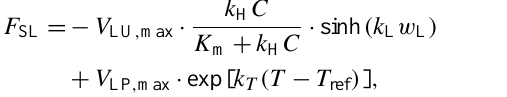
Figure 2. COS solubility function used in this study (pink), ob- tained from regression with Elliott et al. (1989) data (pink). Sol- ubility data measured under pH < 9, non-saline conditions (pink di- amonds) were used for the regression. Also plotted are the COS solubility functions from Wilhelm et al. (1977) and De Bruyn et al.